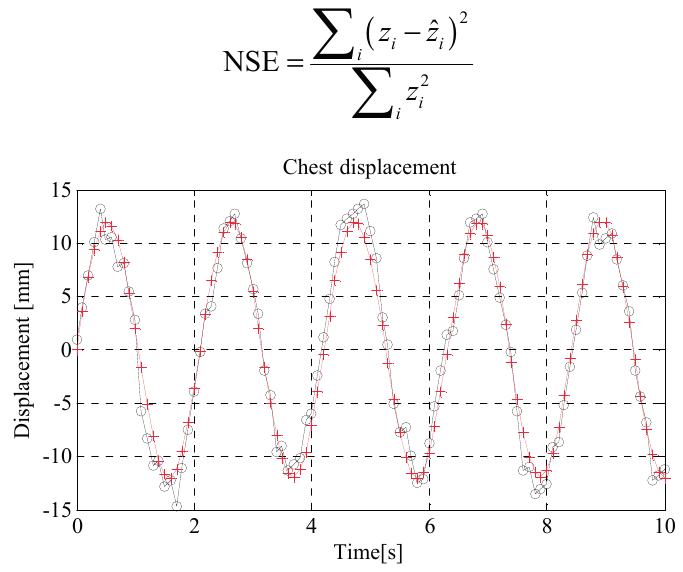
Figure 17. Example of reconstruction of the thorax movement: original waveform (+) against reconstructed waveform